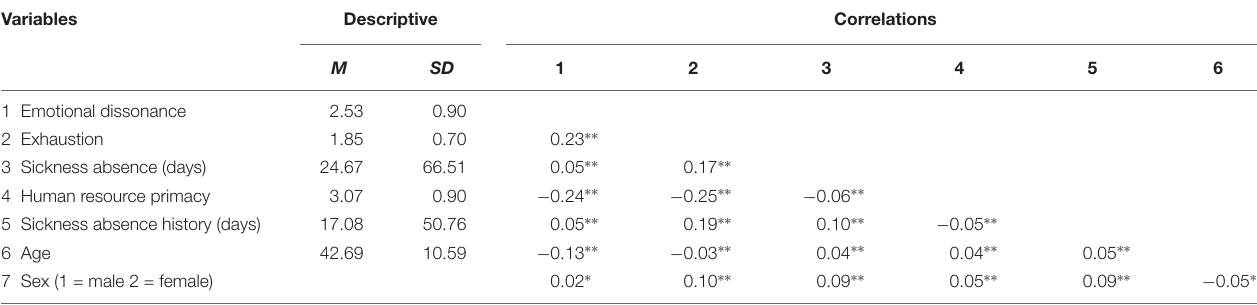
TABLE 1 | Means (M), standard deviations (SD), and intercorrelations for variables included in the moderated mediation model. Variables Descriptive